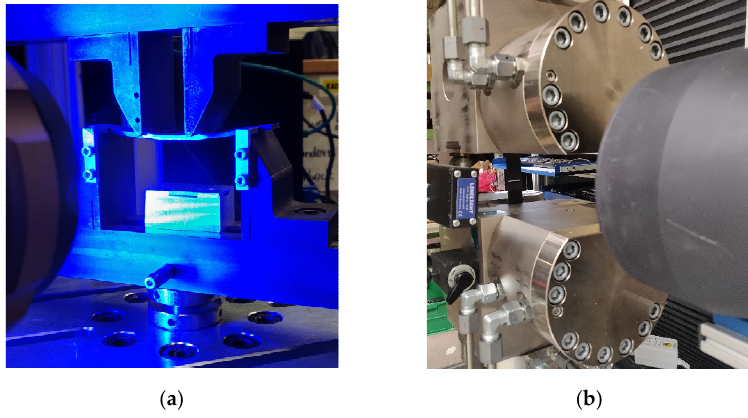
Figure 10. Test setups with video extensometer; ( a ) 4-point bending; ( b ) Tension.